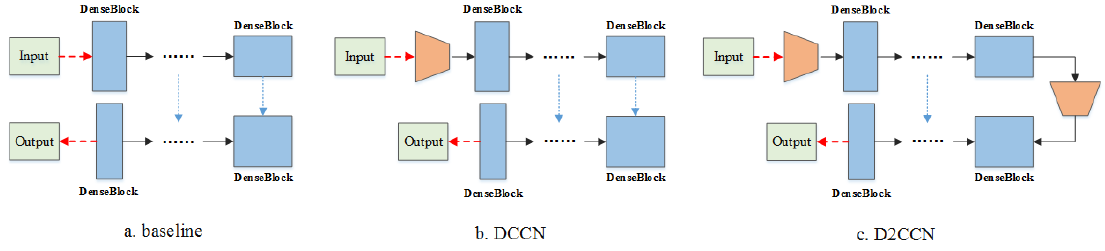
Figure 8. Di ff erent strategies of implementing the coordconv module in the network. Figure 8. Different strategies of implementing the coordconv module in the network. Table7. Thequantitativeresultsofthebaseline, Table 7. The quantitative results of the baseline, D2CCN, and DCCN models with the validation datasets.